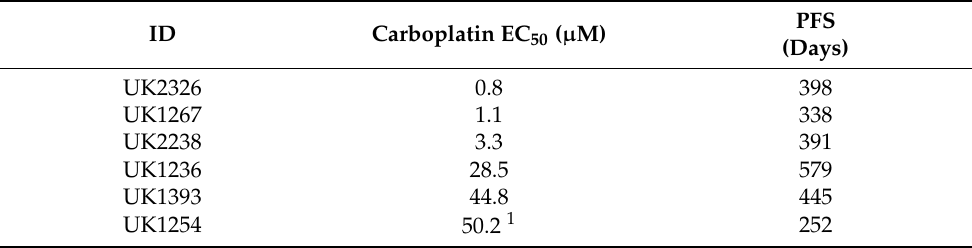
Table 3. Cell viability EC 50 values for each TO cell line when treated with carboplatin and subject progression-free survival